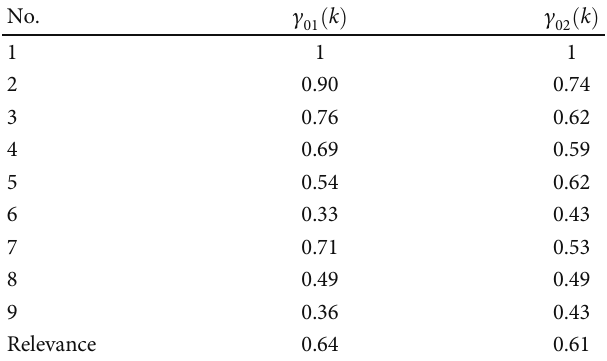
Table 5: Uniaxial compressive strength correlation coe ffi cient results.